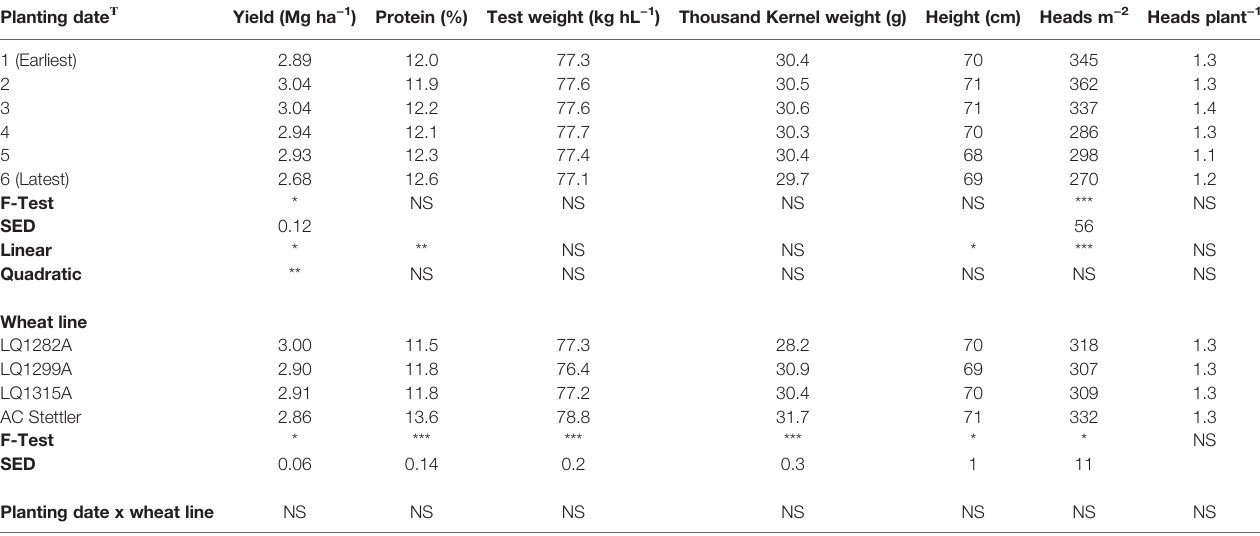
TABLE 5 | Least square means values and signi fi cance of treatment interactions for sites south of 51°N latitude. Planting date Ŧ